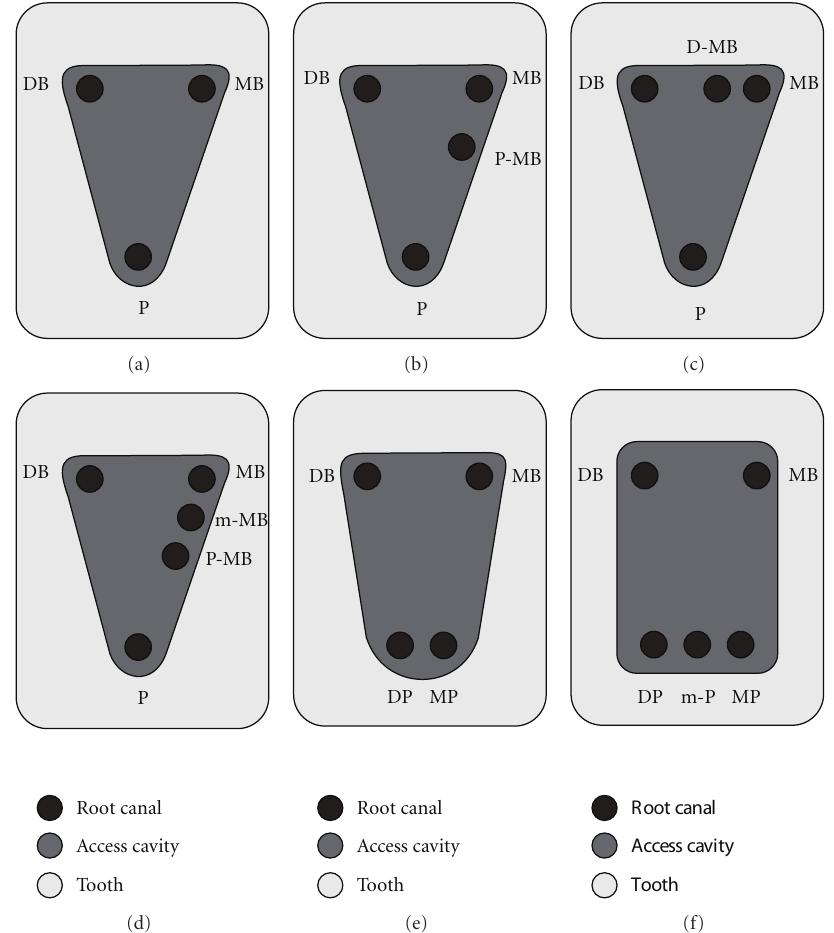
Figure 1: Diagrammatic representation of the various canal configurations in maxillary molars with names according to the proposed nomenclature. (a) The principle canals in maxillary molars are named in accordance with the traditional approach as mesiobuccal (MB), distobuccal (DB), and palatal (P). (b) An additional palatally located mesiobuccal canal is named as palato-mesiobuccal, P-MB. (c) An additional distally located mesiobuccal canal is named as disto-mesiobuccal, D-MB. (d) Two additional palatally located mesiobuccal canals in the mesiobuccal root are named as palato-mesiobuccal, P-MB, and middle-mesiobuccal, m-MB. (e) Two canals in the palatal root are named as mesiopalatal, MP, and distopalatal, DP. (f) Three palatal canals within the same palatal root are named as mesiopalatal (MP), middle-palatal (m-P), and distopalatal